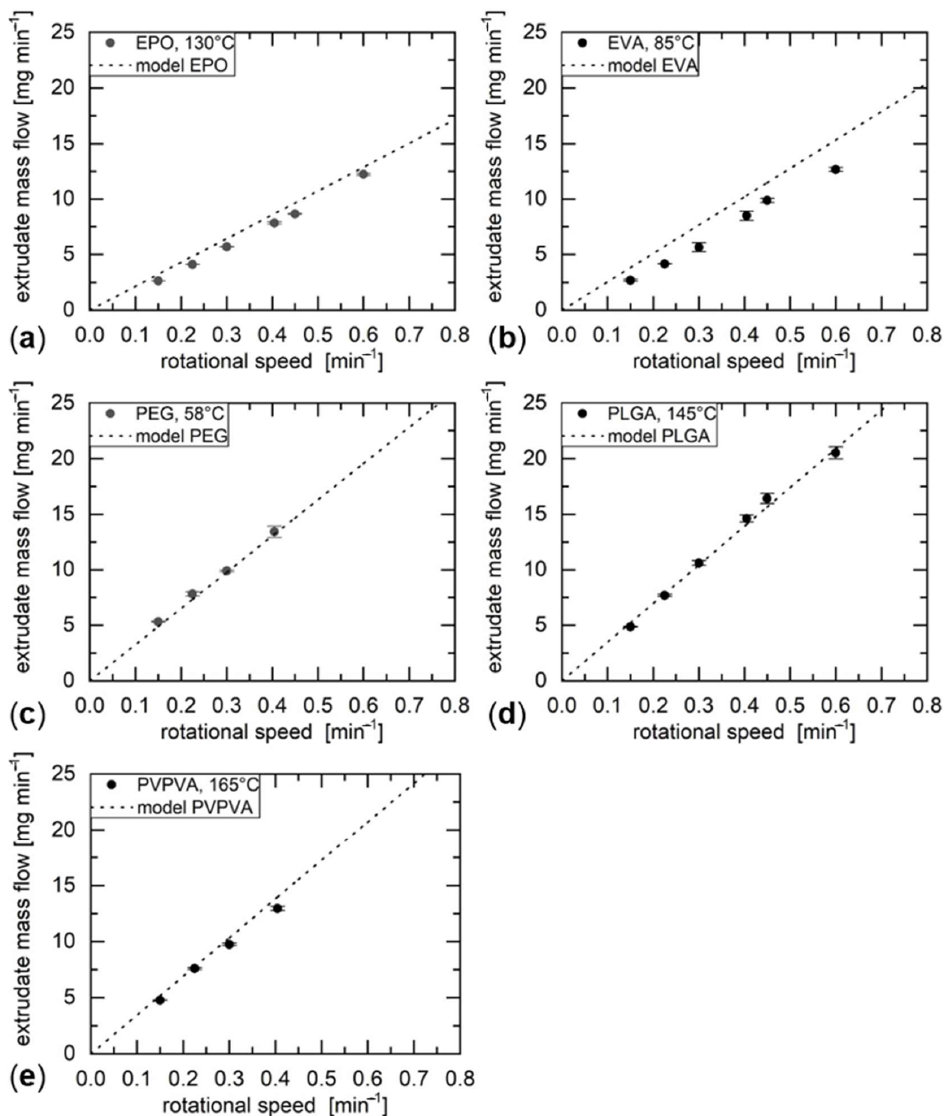
Figure 3. Measured conveying characteristics compared with the model for the investigated materials (( a ) EPO, ( b ) EVA, ( c ) PEG, ( d ) PLGA, ( e ) PVPVA) at their respective minimum extrusion